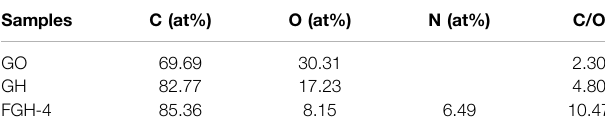
TABLE3| ElementalcontentandC/Oratios,asobtainedbyXPSsampleanalysis.